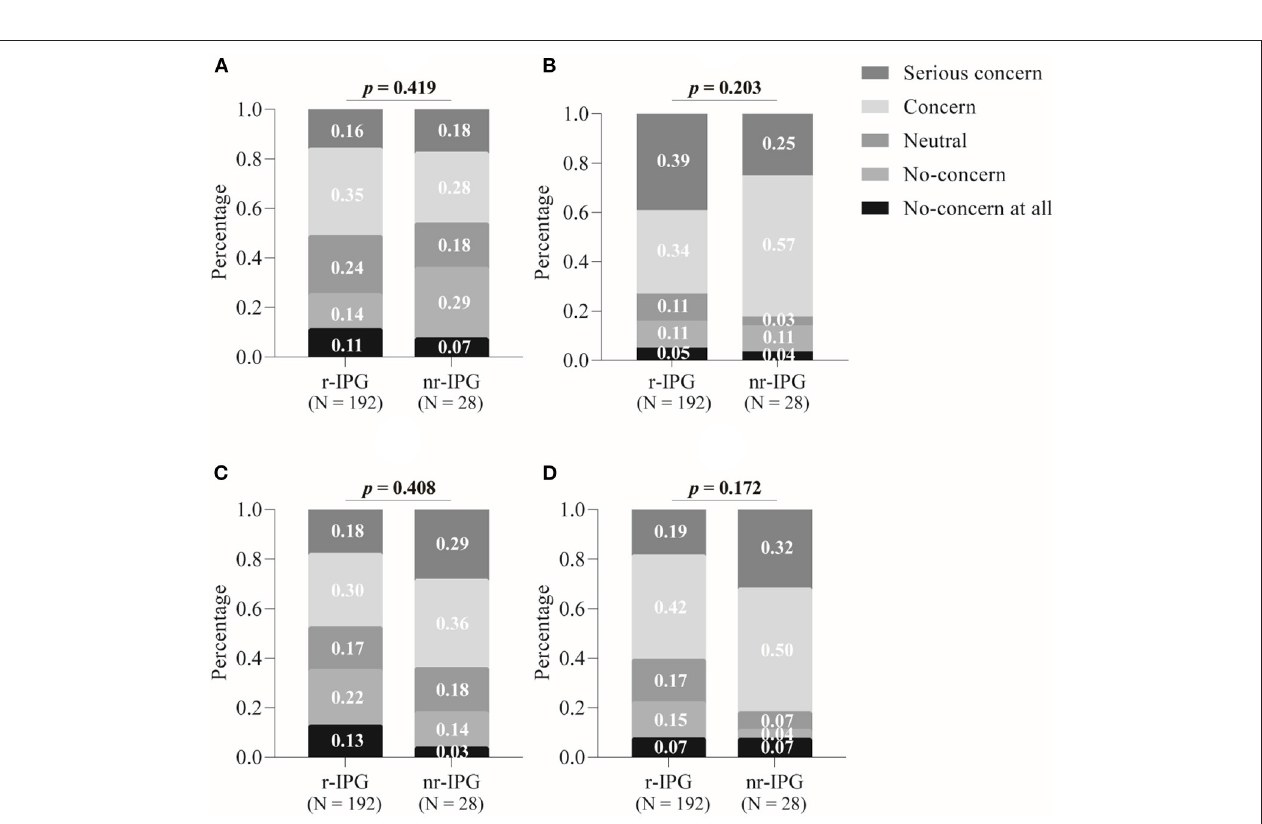
FIGURE 2 | Factors influencing patient’s choice between a rechargeable (r-IPG) and non-rechargeable (nr-IPG) implanted pulse generator. (A) Battery size; (B) the need for further surgery to replace the battery; (C) the need for recharging the battery; and (D) economic issues. Patients’ attitudes toward these factors were divided into five levels in the questionnaire: “No concern at all”, “No concern”, “Neutral”, “Concern”, and “Serious concern”. Data are presented as percentages. A p -value < 0.05 is considered statistically significant.